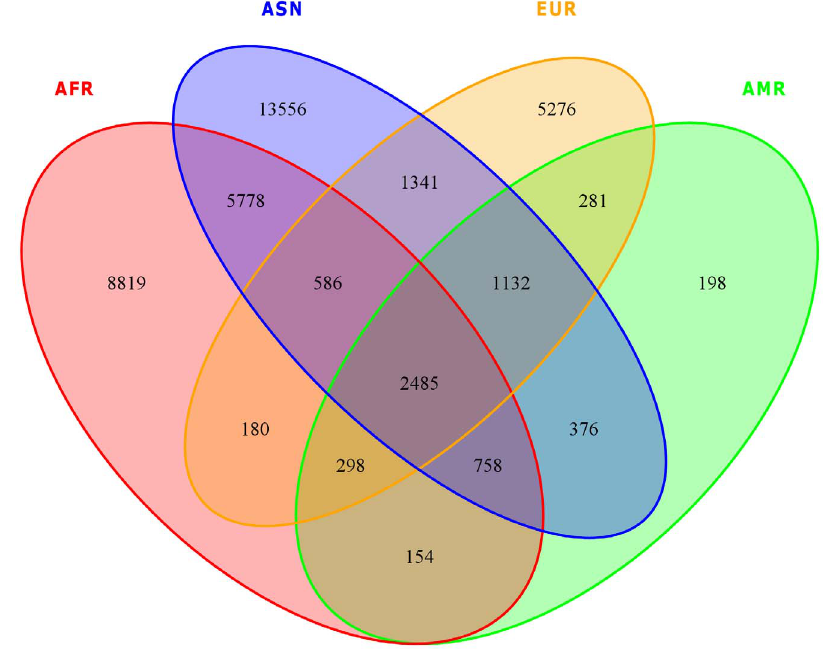
Figure 4. Venn diagram depicting the number of SNPs having significant difference in allele frequencies between the KWS group and other continent populations from the 1000 Genomes Project (F st . 0.25 & q-value , 0.05).